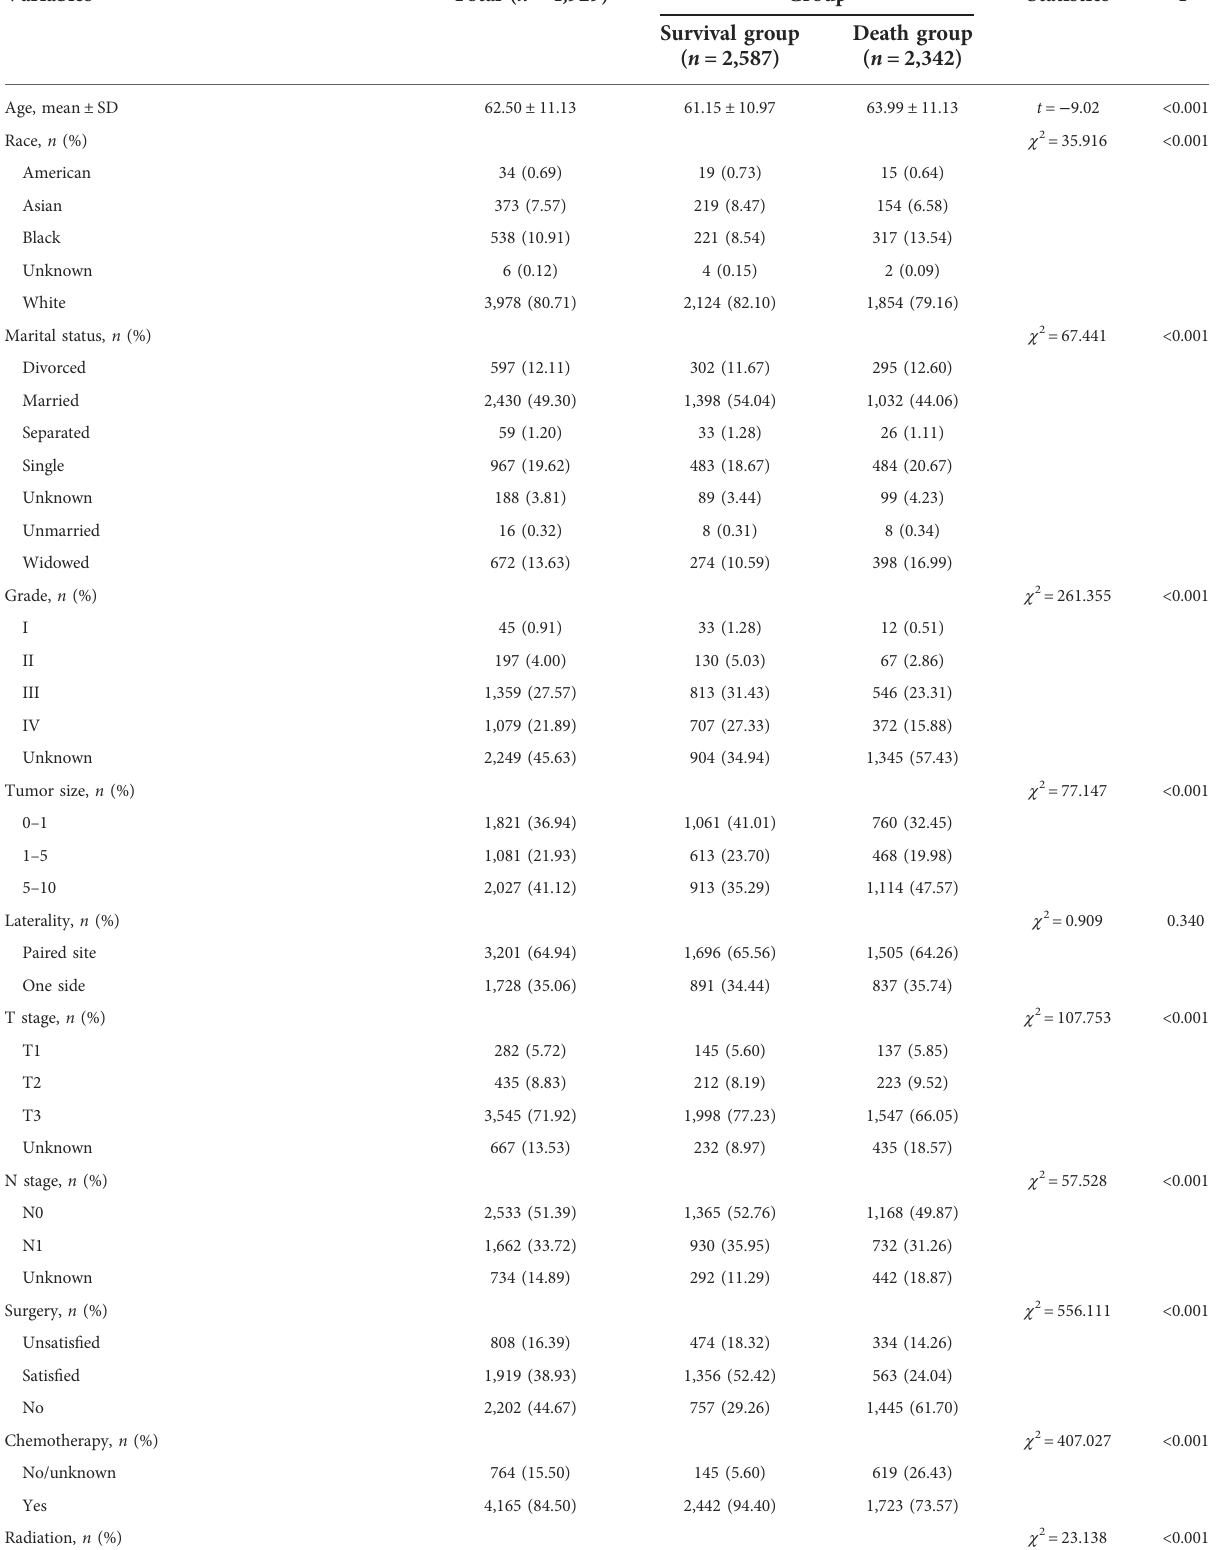
TABLE 1 Comparisons of the characteristics of patients in the survival group and death